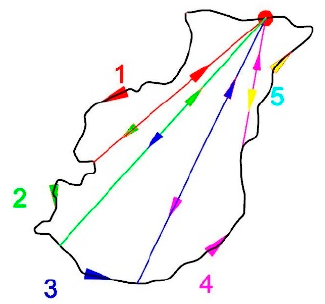
Figure 4. Road exploration diagram.